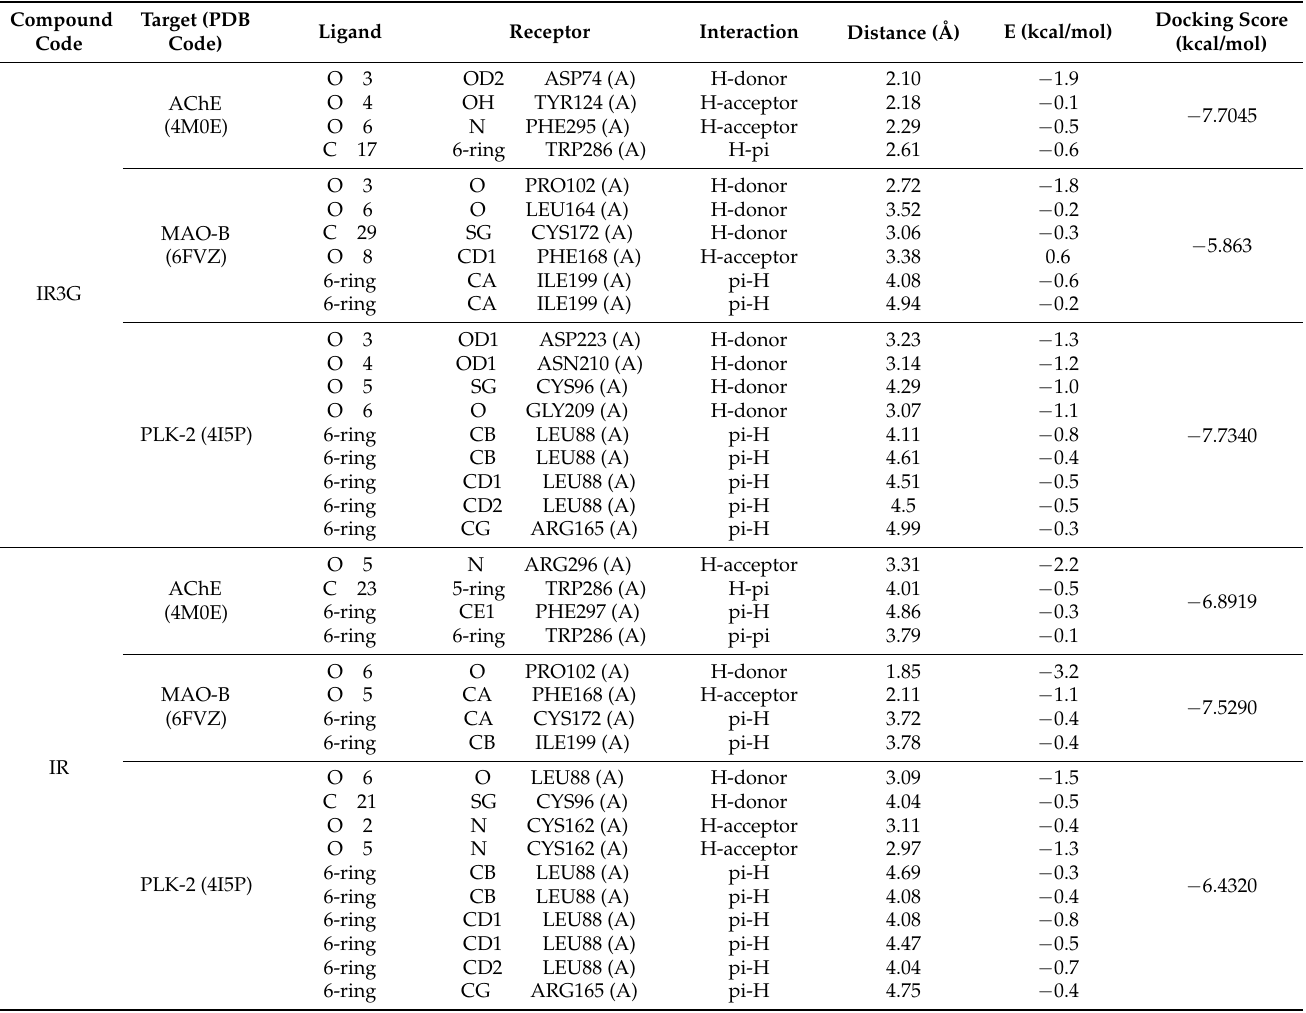
Table 2. Docking energy and interaction of IR3G and IR with target proteins (4M0E, 6FVZ, and 4I5P). Compound